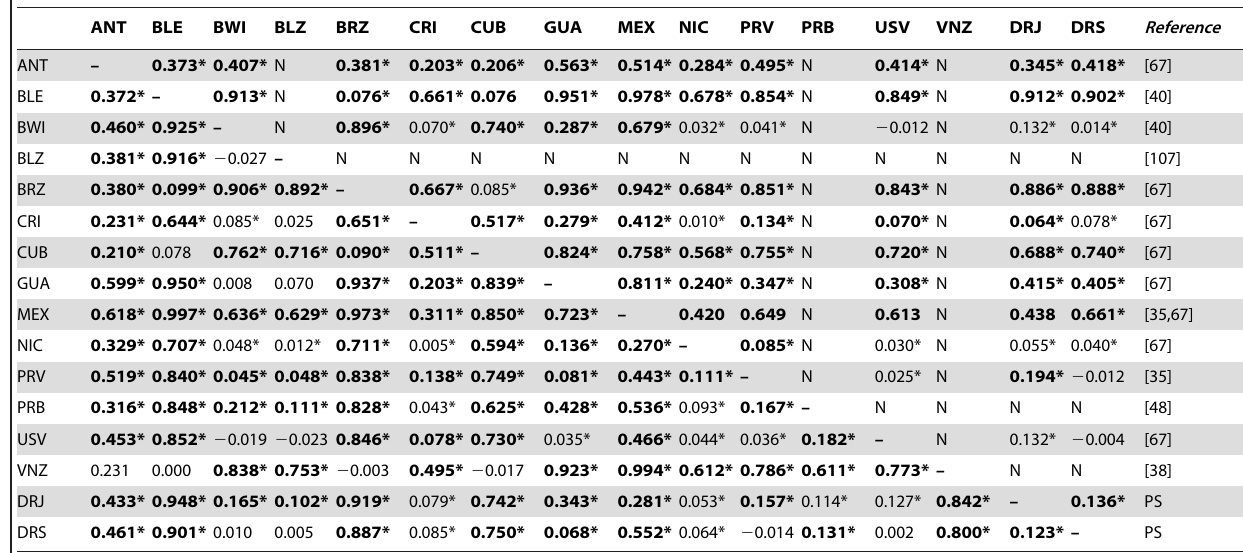
Table 3. Genetic distances ( W st ) between Caribbean hawksbill nesting